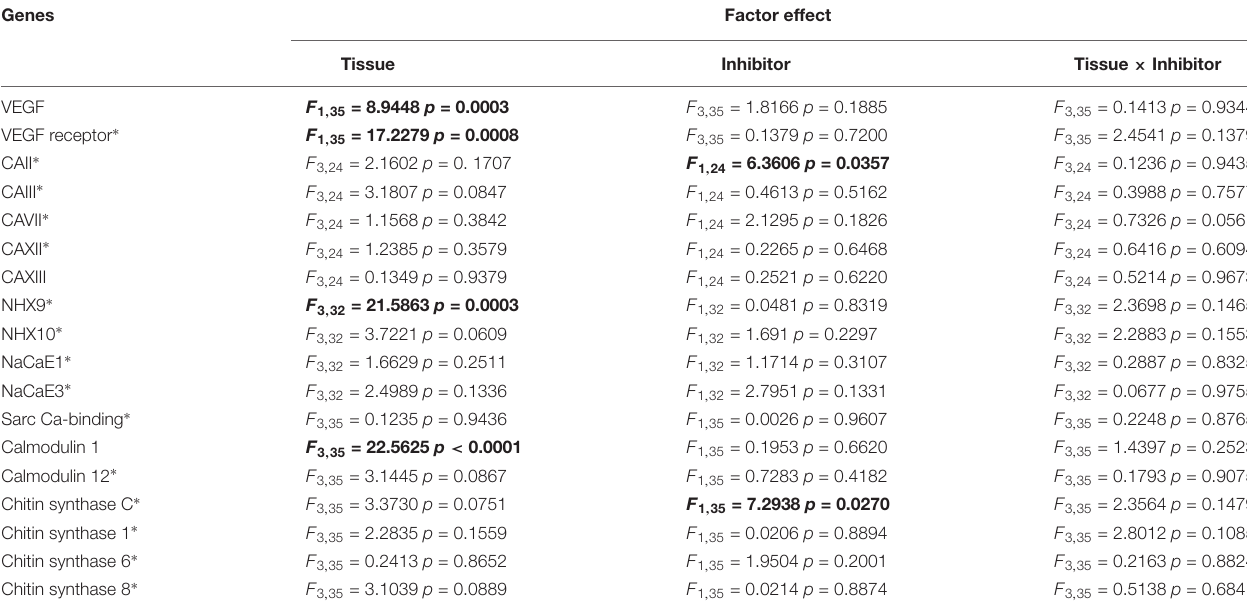
TABLE 2 | ANOVA: Effects of the axitinib on the expression of biomineralization mRNAs in Crassostrea gigas . Genes Factor effect